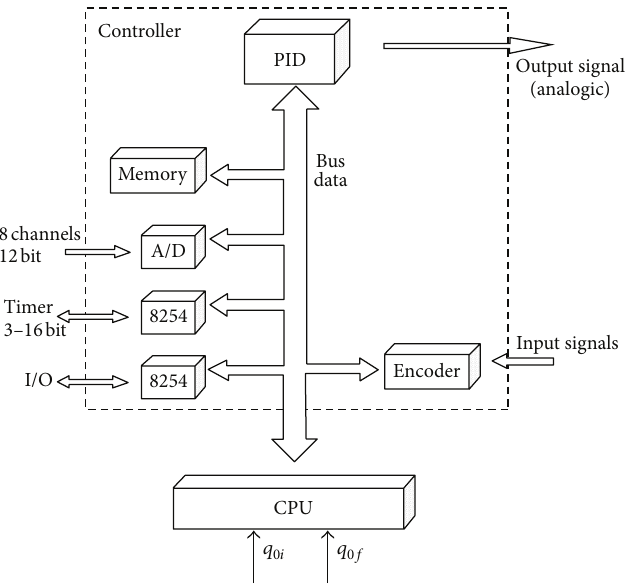
Figure 11: Functional scheme of the PID controller.